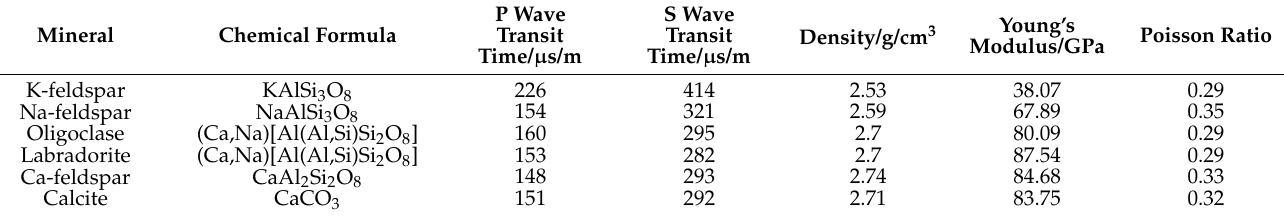
Table 1. Calculation of petro-physical parameters of the studied minerals.